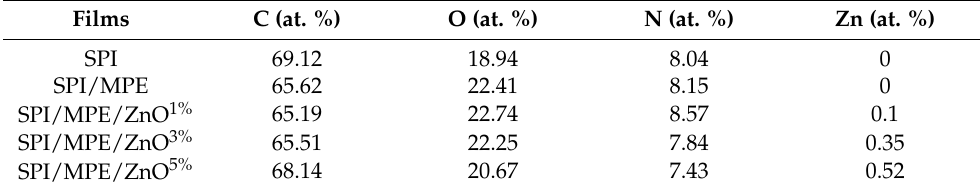
Figure 6. XPS survey spectra of SPI films ( a ) and XPS of C 1s features of SPI films for SPI control ( b ), SPI/MPE ( c ), SPI/MPE/ZnO 1% ( d ), SPI/MPE/ZnO 3% ( e ) and SPI/MPE/ZnO 5% ( f ) film, respectively. Table 4. The peak area is measured by